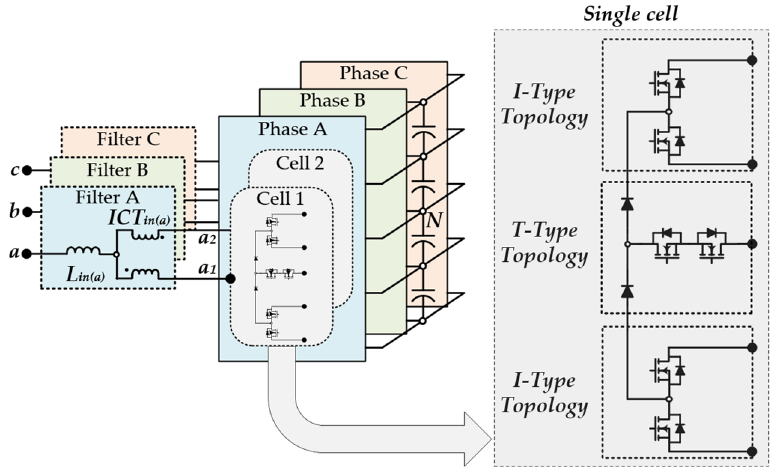
Figure 2 . Circuit of 3 Φ 5L E-Type Multilevel–Multicell Rectifier (MMR).